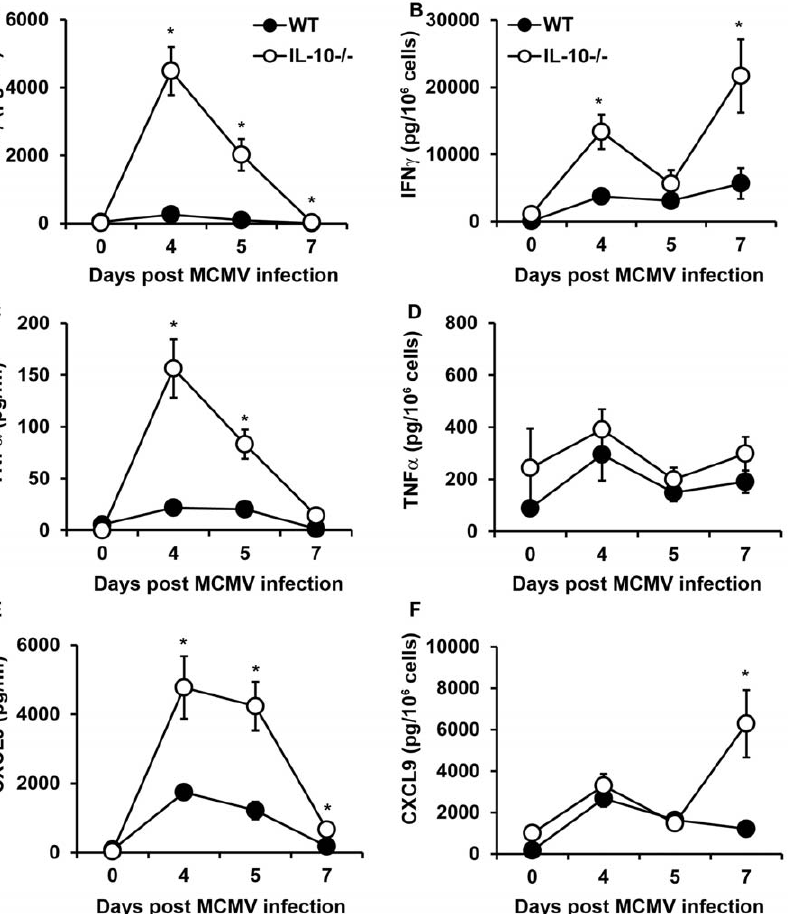
Figure 3. Effects of IL-10 deficiency on systemic and local proinflammatory cytokine and chemokine production after acute MCMV infection. (A, C, E) Serum samples and (B, D, F) liver leukocyte conditioned media were prepared from uninfected or MCMV-infected C57BL/6J (WT) or IL-10 2 / 2 mice and tested for (A and B) IFN- c , (C and D) TNF- a , and (E and F) CXCL9 by standard sandwich ELISA. Results are the combined data of two to four independent experiments and show the means 6 SE (n=5–18 mice per group for each time point tested). Asterisks denote statistically significant differences between WT and IL-10 2 / 2 groups, where p values are # 0.05 (Student’s T test).